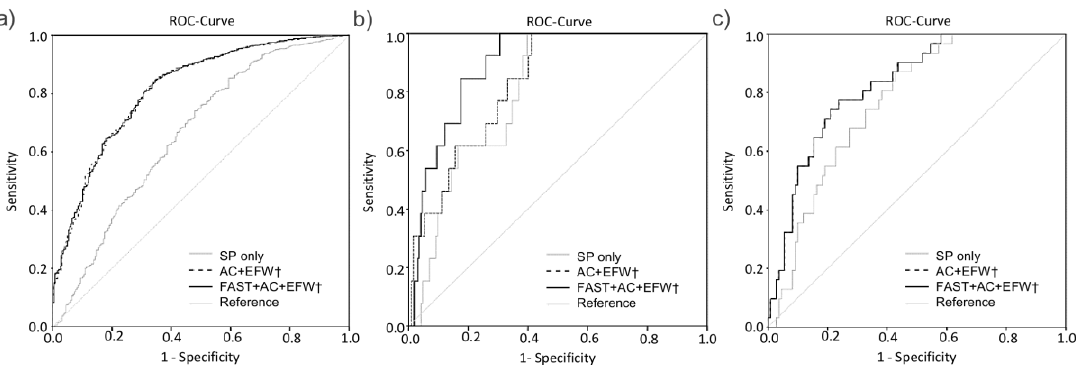
Figure 3. Receiver operating curves (ROC curves)for standard clinical parameters (SP) ( ; light grey), standard clinical parameters combined with standard ultrasound parameters abdominal circumference (AC) and estimated fetal weight (EFW) ( - - - ; broken black line) and with additional inclusion of FAST (fetal abdominal subcutaneous tissue)measurement ( ; black) in prediction of LGA in the entire cohort ( a ) in prediction of hypoglycemia in the subgroup of fetuses with an AC > 75th percentile ( b ) and for C-section when the fetus is growing below the 10th percentile ( c ). † means SP is included.